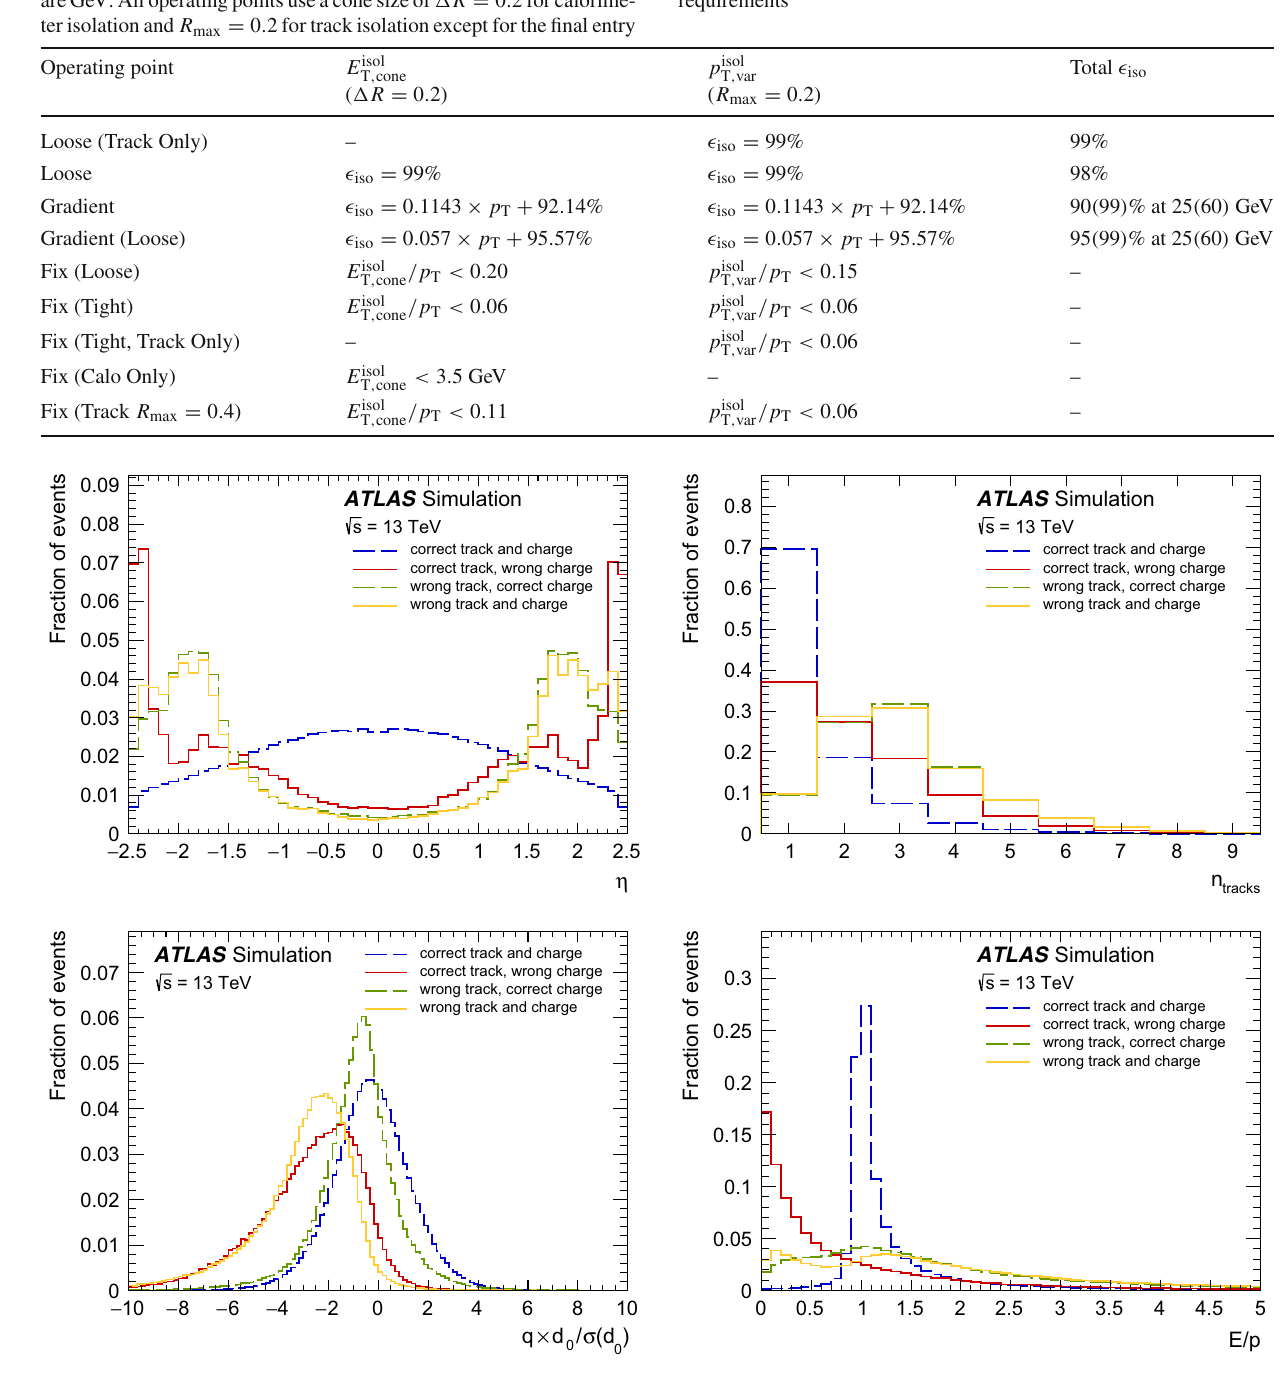
Fig. 13 Kinematic and tracking properties of electrons from a simu- lated Z → ee sample. Top, left: track pseudorapidity. Top, right: mul- tiplicity of associated tracks. Bottom, left: electric charge multiplied by the transverse impact parameter significance. Bottom, right: energy- to-momentum ratio, in each case for electrons with the correctly and